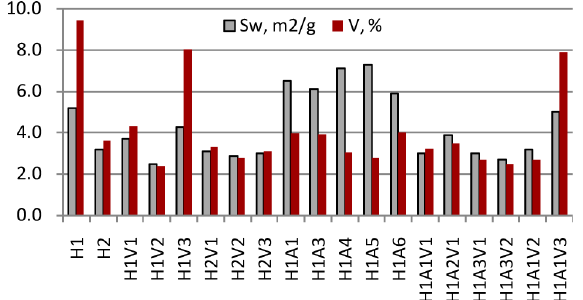
Fig. 4. The research results of open porosity of HPSCC by the mercury intrusion method (MIP)